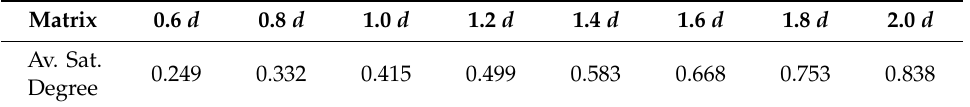
Table 3. Average saturation degrees on the small